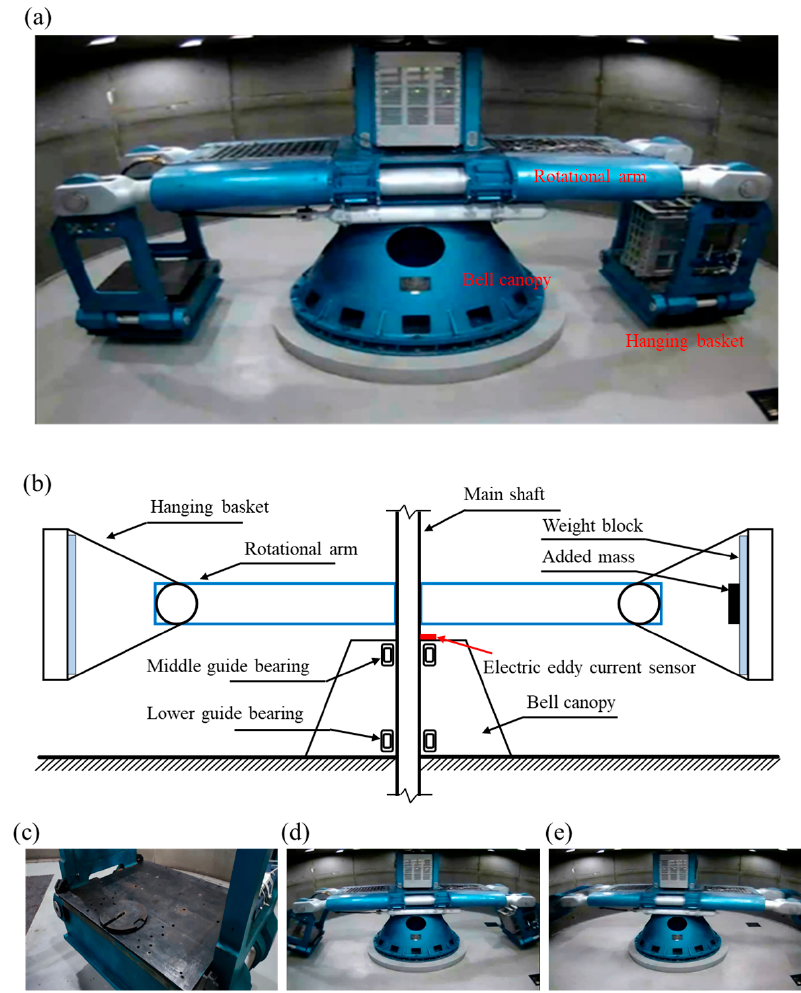
Figure 3. The ZJU-400 hypergravity centrifuge’s structure. ( a ) The main structure. ( b ) Schematic showing the rotor system and sensor arrangement position. ( c ) Artificially added mass before operation. ( d ) Operating condition at low centrifugal acceleration. ( e ) Operating condition at high centrifugal acceleration.